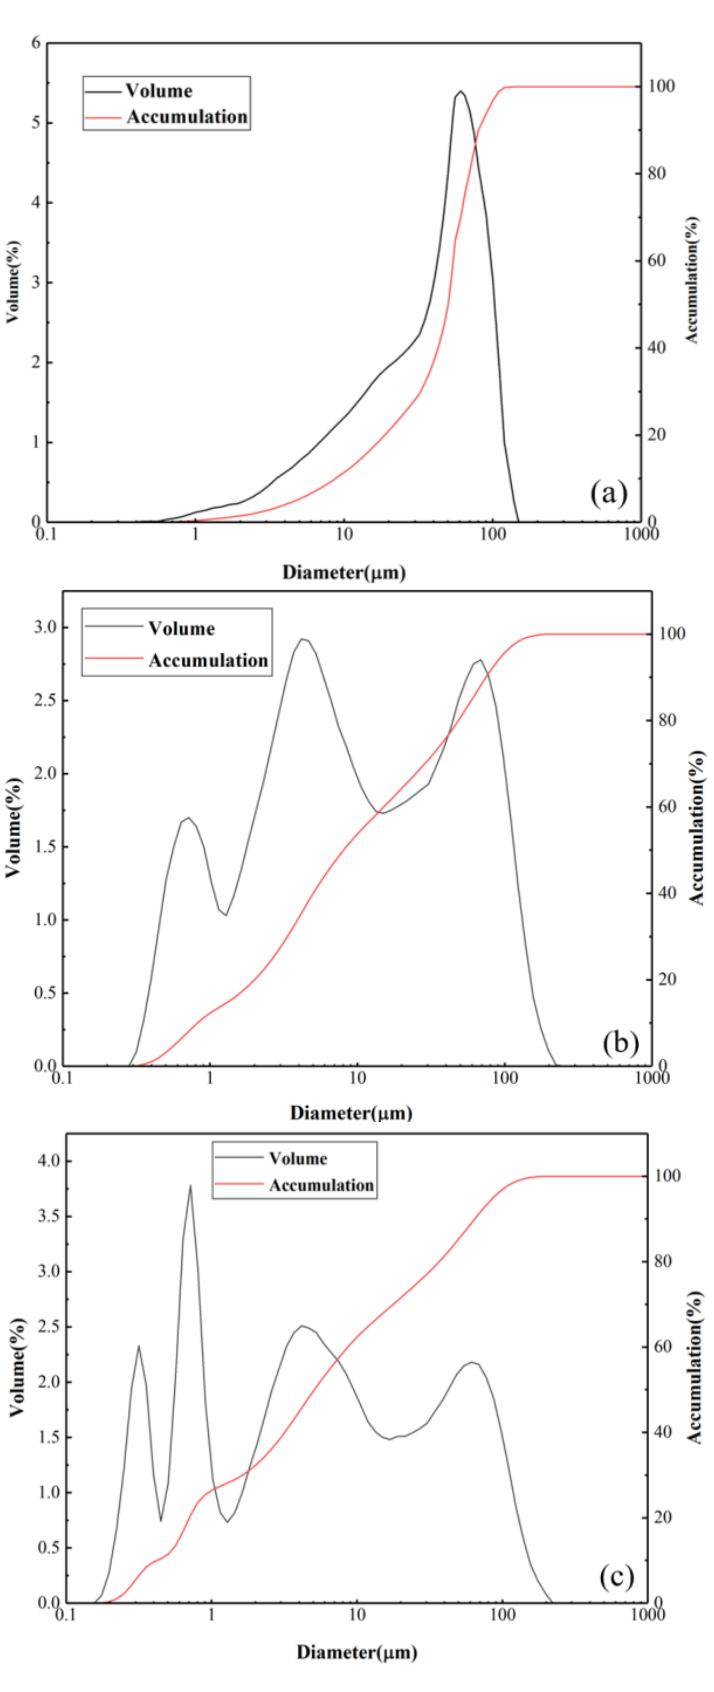
Figure 2. Particle size distribution of materials: ( a ) PG, ( b ) limestone, ( c ) bauxite.